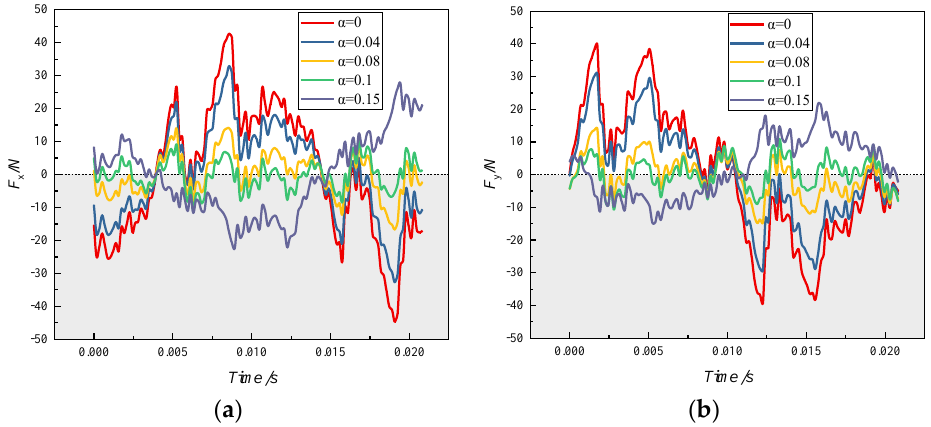
Figure 10. The time-domain distribution of the radial force component of the impeller under different inlet gas fractions: ( a ) x direction; ( b ) y direction.